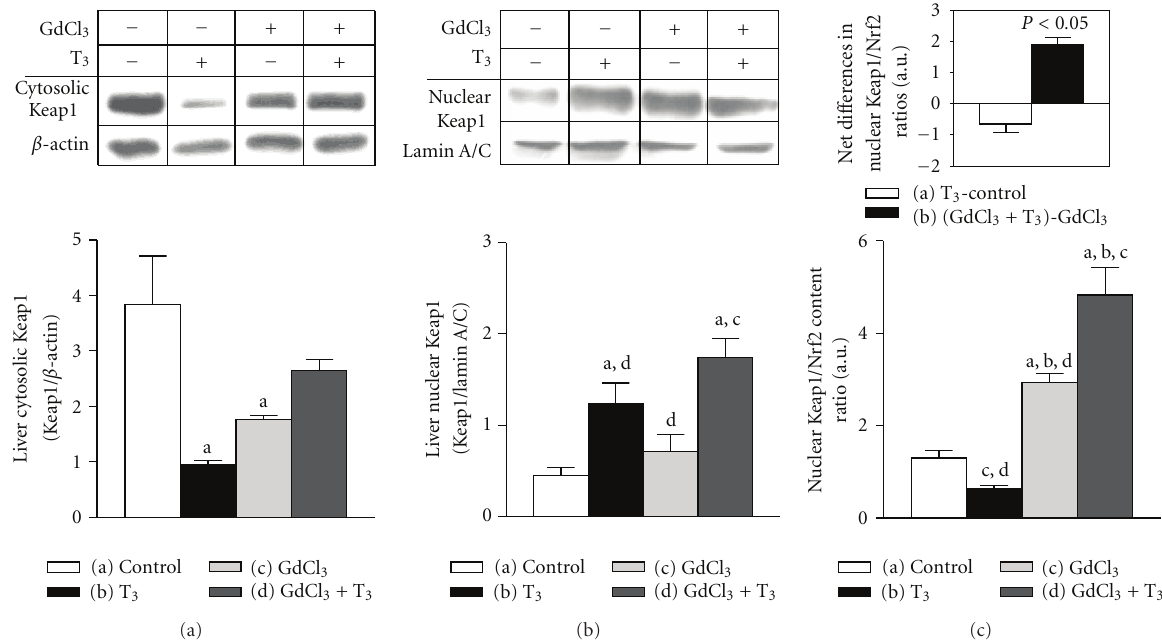
Figure 3: Gadolinium chloride (GdCl 3 ) administration is associated with enhancement of liver Keap1/Nrf2 ratios over values in T 3 -treated rats. Determinations were performed at 2h after T 3 administration in rats pretreated with GdCl 3 for 72h. (a) Levels of cytosolic Keap1 protein (70kDa) and β -actin (43kDa); (b) levels of nuclear Keap1 protein and lamin A/C (65kDa); (c) nuclear Keap1/Nrf2 content ratios and net e ff ects of T 3 and GdCl 3 treatments ( inset) . Values shown represent means ± SEM for 4 to 6 rats per experimental group. Significance ( P < 0 . 05; two-way ANOVA and the Newman-Keuls’ test) is indicated by the letters identifying each experimental group. Significance in the inset of (c) was calculated by Student’s t -test for unpaired data.